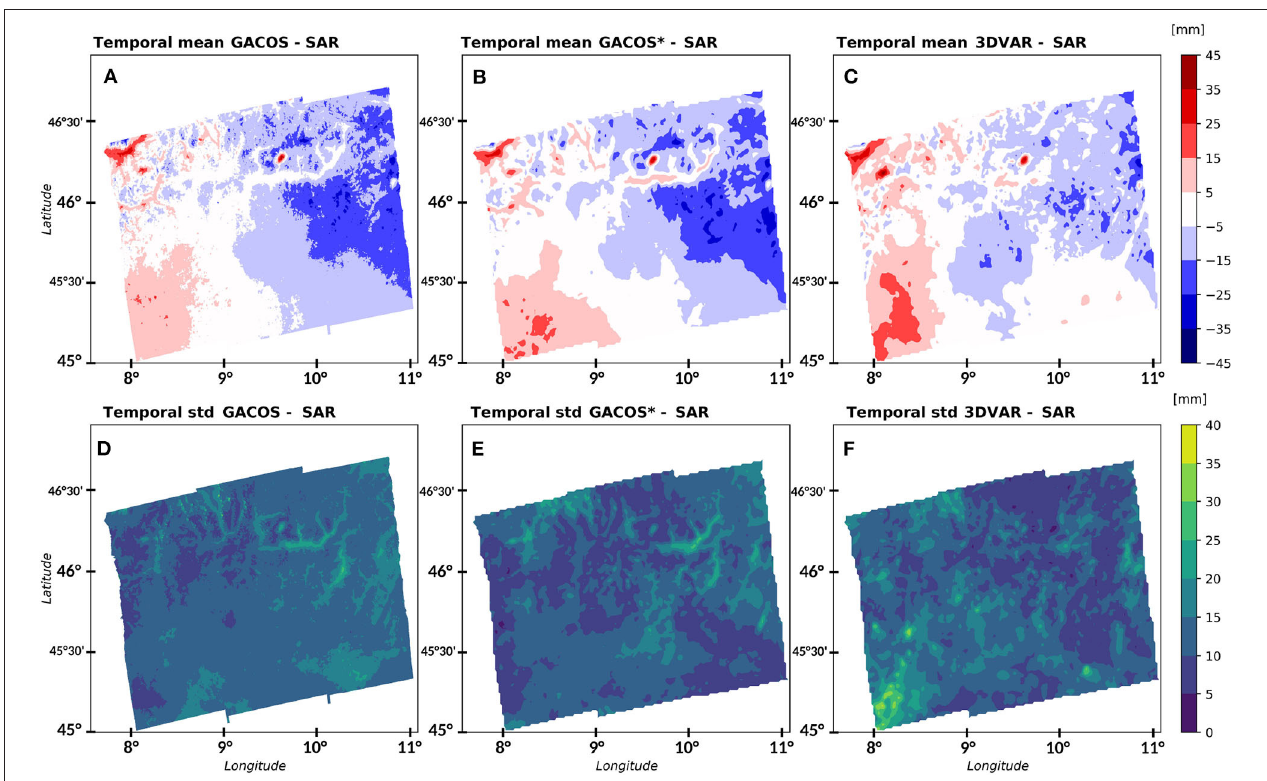
FIGURE 6 | Map of the temporal statistics, mean and standard deviations, of the difference between the models 1 ZTD maps and the SAR 1 ZTD maps. (A,D) For GACOS at its original spatial resolution and using the entire data set; (B,E) for GACOS undersampled on the 3DVAR grid and considering only the dates where 3DVAR is available; (C,F) for